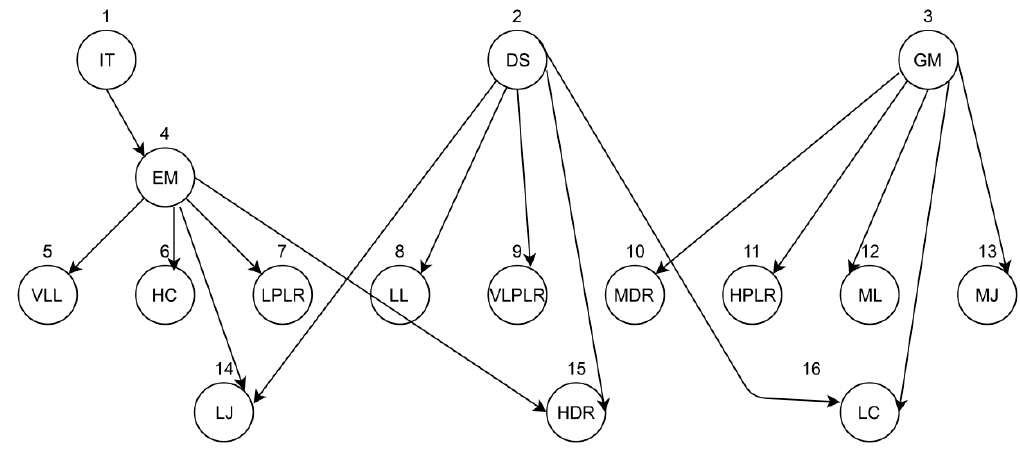
Figure 2. Bayes network model for telemedicine.